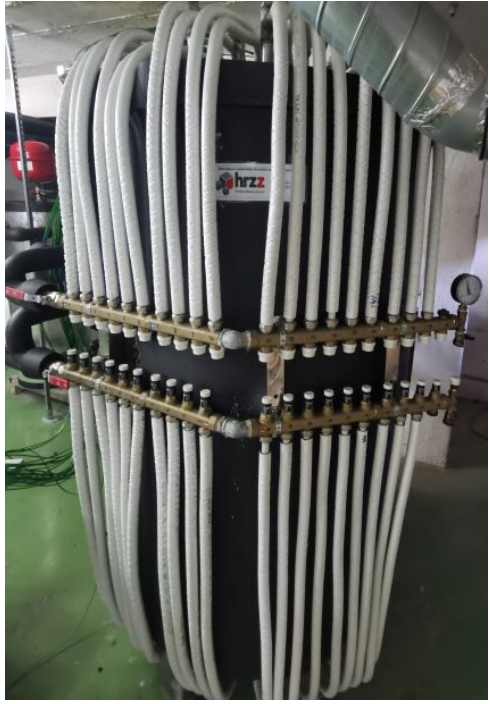
Figure 8. Experimental LTES tank.